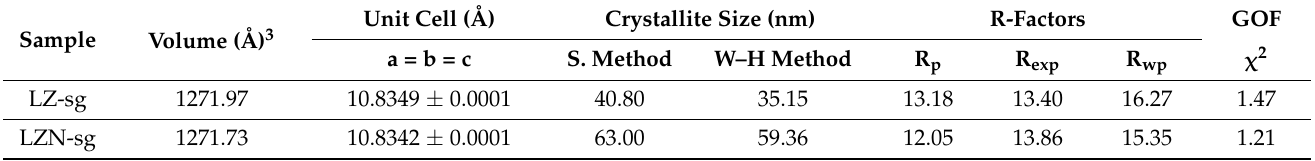
Table 2. Typical atomic coordinate (x, y, z), sites and occupancies of different atoms for La 2 Zr 2-x Ni x O 7 pyrochlores. Sample